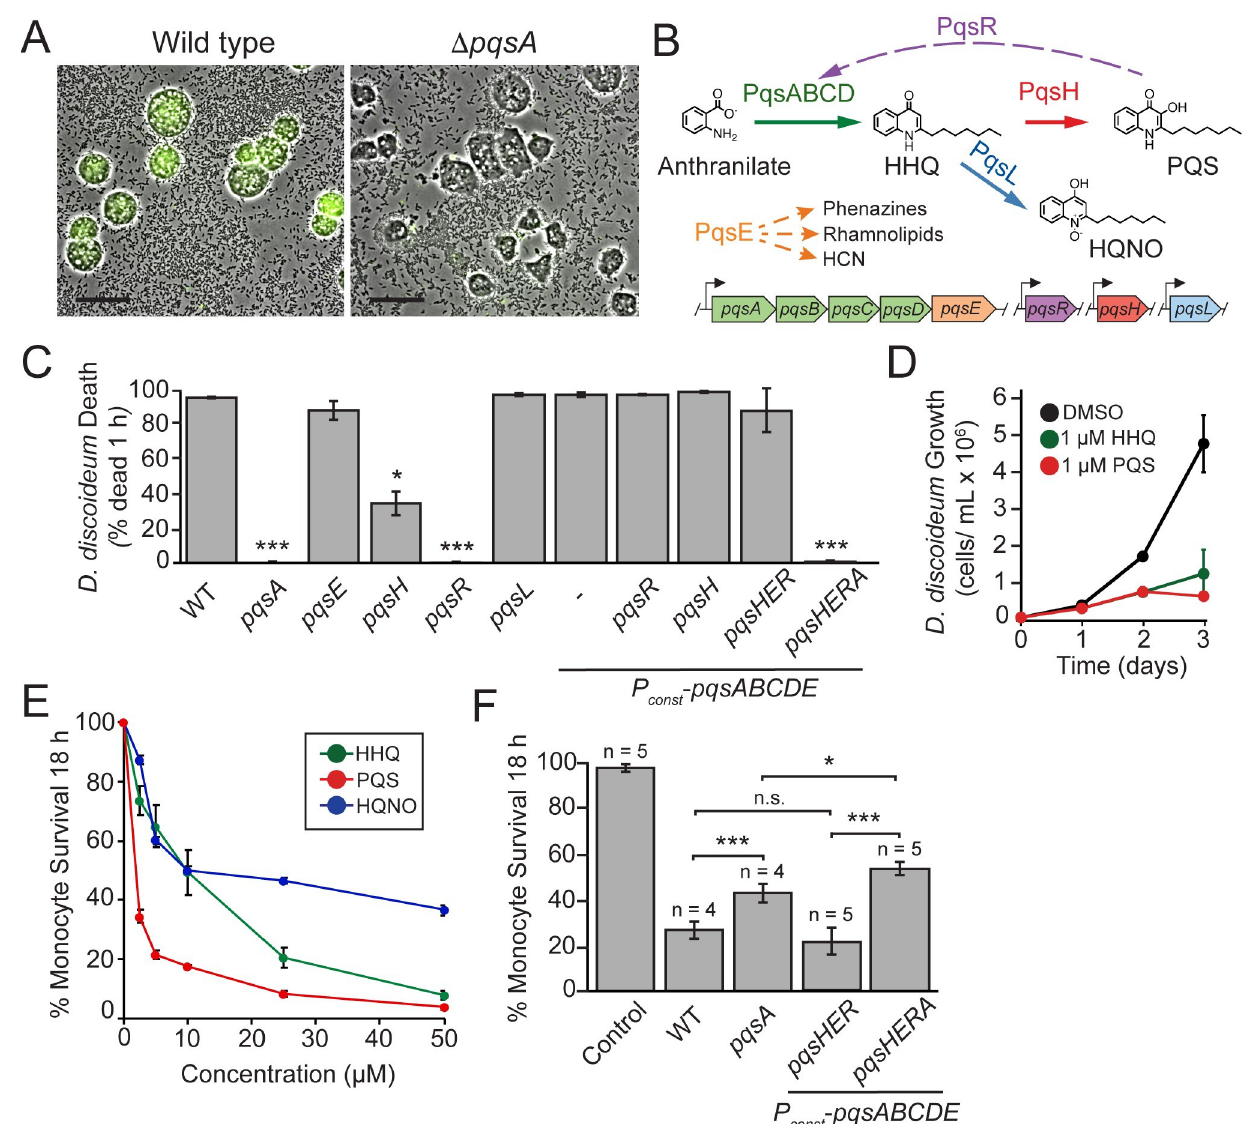
Fig 1. Alkyl-quinolone production is necessary and sufficient for surface-induced killing of D . discoideum by P . aeruginosa . (A) Representative images of D . discoideum infected with surface-attached wild type and Δ pqsA P . aeruginosa after 1 h co-culture (scale bars = 30 μ m). Fluorescent calcein- AM staining indicates cell death. (B) Schematic of the PQS pathway depicting the functions of relevant genes. Solid and dotted arrows represent biosynthetic reactions and gene regulation, respectively. Genes above arrows indicate genetic requirements for pathways. (C) Quantification of D . discoideum killing by PQS pathway mutants. Expression of pqsABCDE is driven by the endogenous pqsA promoter or a strong constitutive promoter inserted upstream of the pqsA gene ( P const − pqsABCDE ). Values are mean ± SEM from 3 biological replicates, and approximately 200–300 cells were analyzed for each measurement. (D) Cytotoxicity of purified HHQ and PQS to D . discoideum in axenic cultures grown for 3 days at 22˚C. Values are mean ± SD of five biological replicates (n = 5). E) MTT cell viability assay of TIB-67 mouse monocytes after 48 h of treatment with various concentrations of the alkyl-quinolones HHQ, PQS, or HQNO in a 96-well format. Percent survival is relative to an untreated control. Values are mean ± SEM of three biological replicates (n = 3). (F) Quantification of survival of TIB-67 monocytes after 18 h co-cultured with surface-attached P . aeruginosa . Values are mean ± SEM of 4–5 biological replicates (n = 4–5). Approximately 2500–3000 cells were analyzed for each measurement. For statistical analysis, mutants were compared to wild type unless shown otherwise. Statistical analyses are Student’s t-test (two-tailed, � = p < 0.05, �� = p < 0.01, ��� = p <